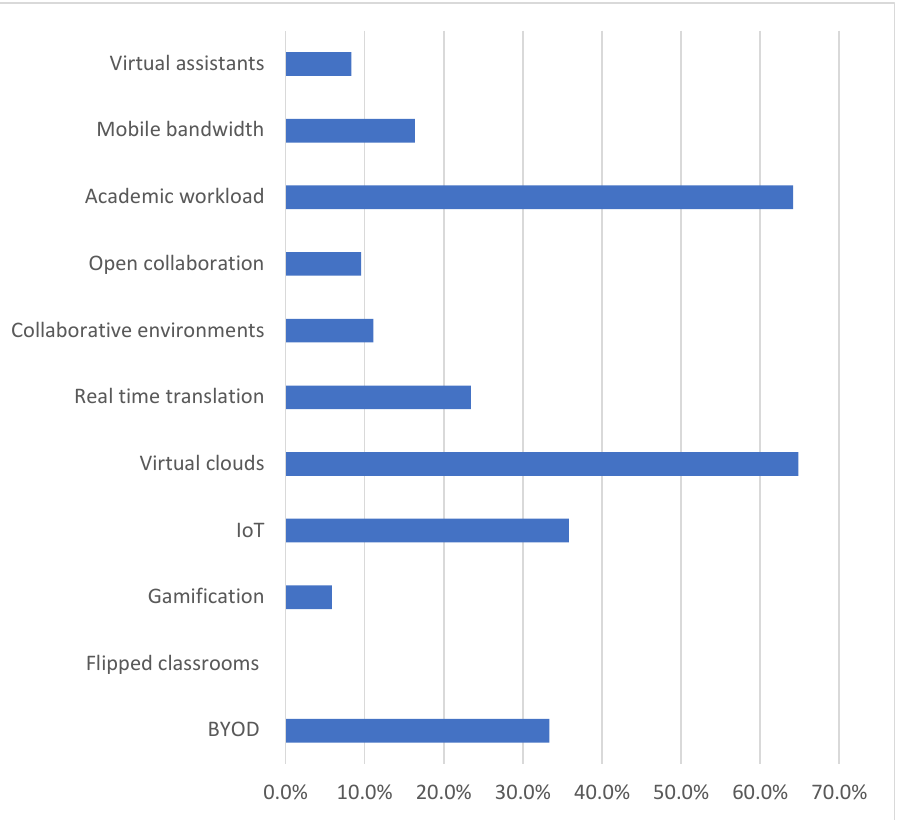
Figure 2. Use of emerging technologies.